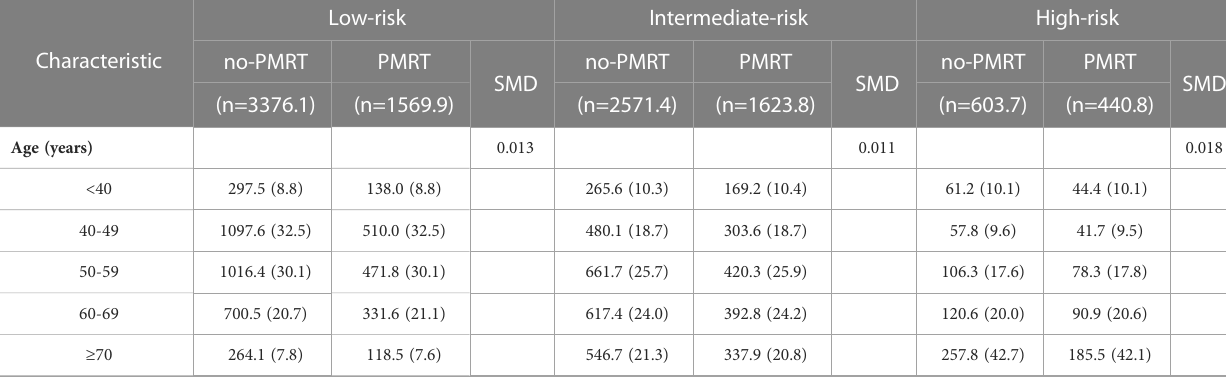
TABLE 4 The baseline characteristics of the patients in the IPTWs-adjusted cohort based on BCSS.